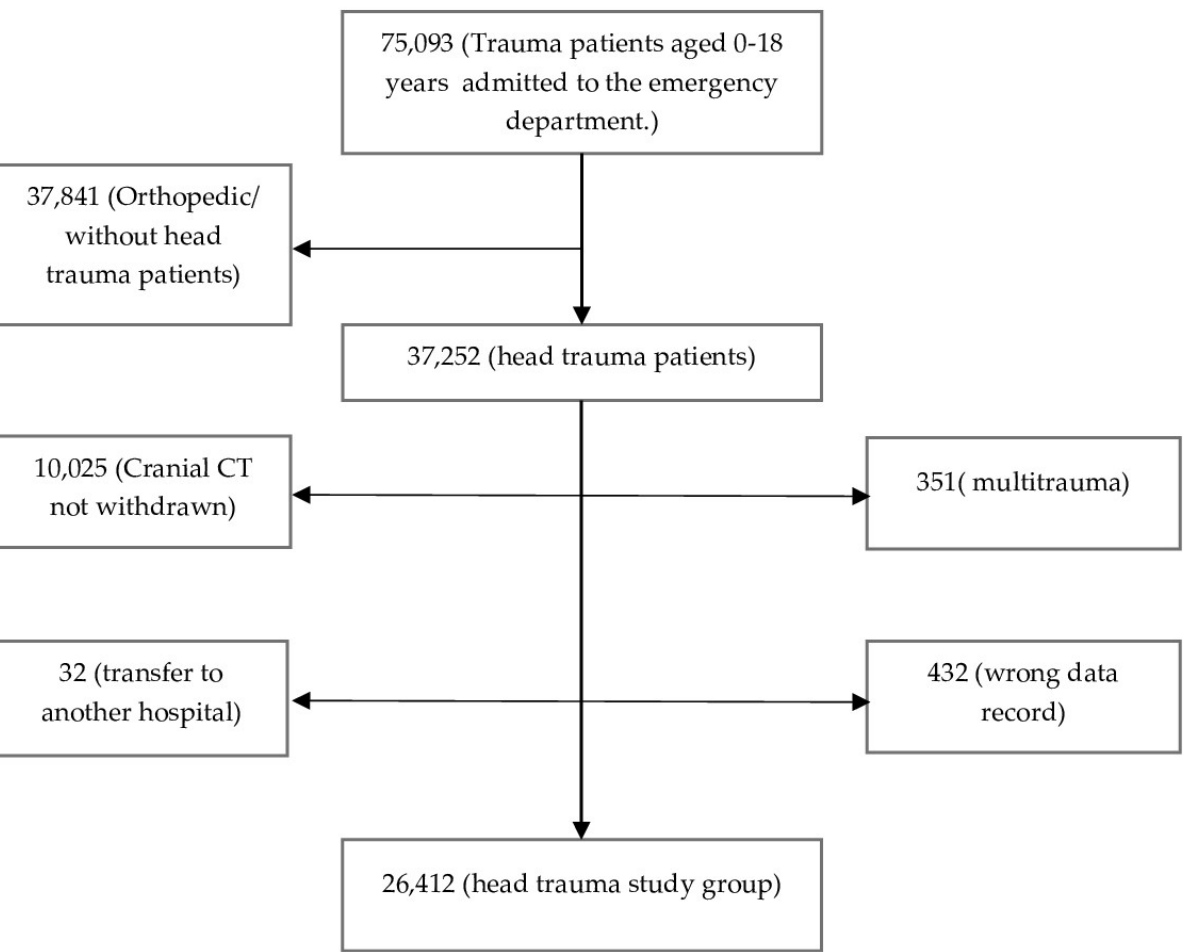
Figure 1. Flowchart of the participants.